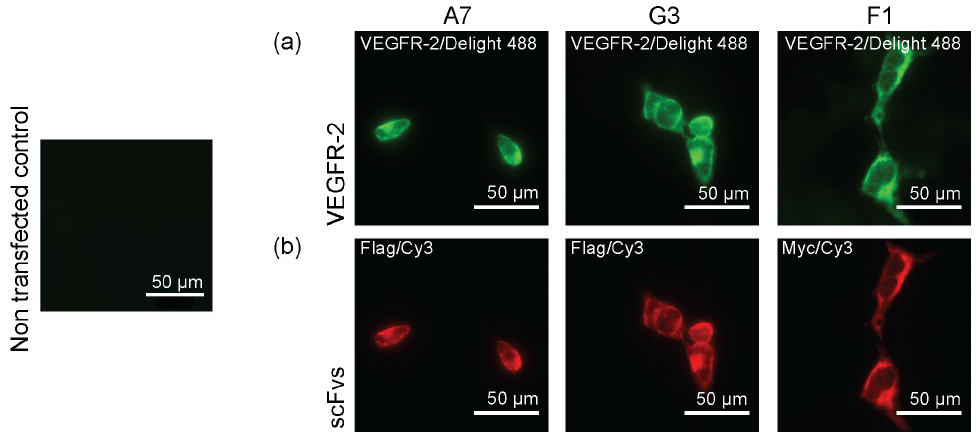
Figure 2. ScFvs bind VEGFR-2 expressed on the surface of HEK293 cells. ( a ) VEGFR-2 was detected with commercial primary VEGFR-2 antibody and fluorescently-labeled secondary antibody (green); ( b ) For ScFvs staining, myc-tag (scFvs G3 and F1) and flag-tag (scFv A7) primary antibodies were used, followed by secondary fluorescently-labeled antibodies (red). Bound ScFvs show the same binding pattern as commercial VEGFR-2 antibody. Non-transfected HEK293 cells were used as negative control.